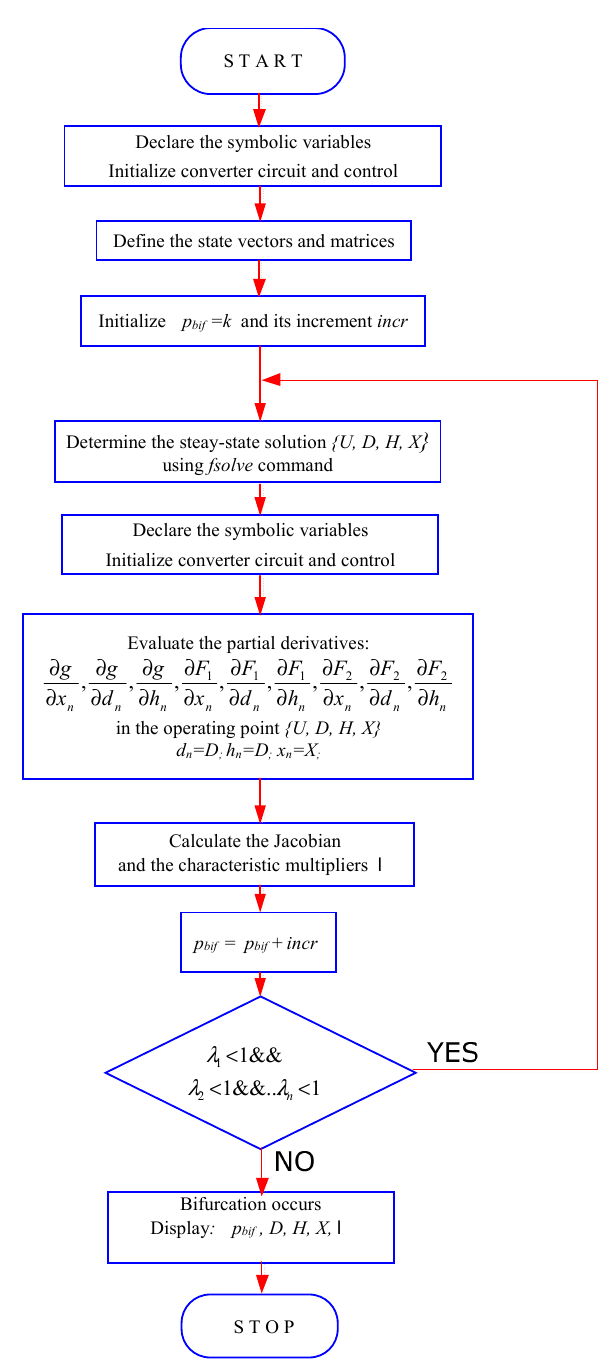
Figure 3. Flow chart of the Matlab™ program for determining the critical bifurcation parameter value.